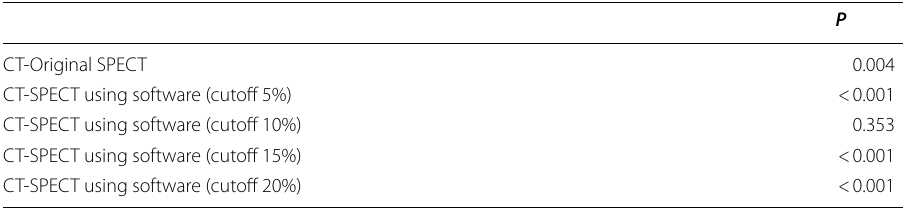
CT, computed tomography; SPECT, single-photon emission computed tomography Table 3 Conformity of the lung volume between calculated from CT and SPECT using Dunnett’s test